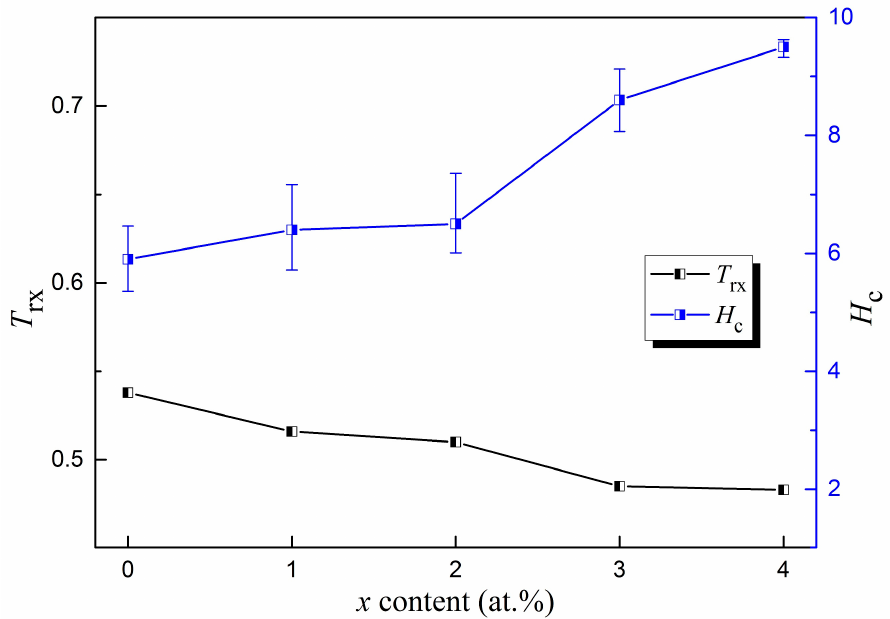
Figure 8. Changes in T rx and H c of the Fe 80+x Si 5 − x B 15 ( x = 0–4) amorphous alloys.